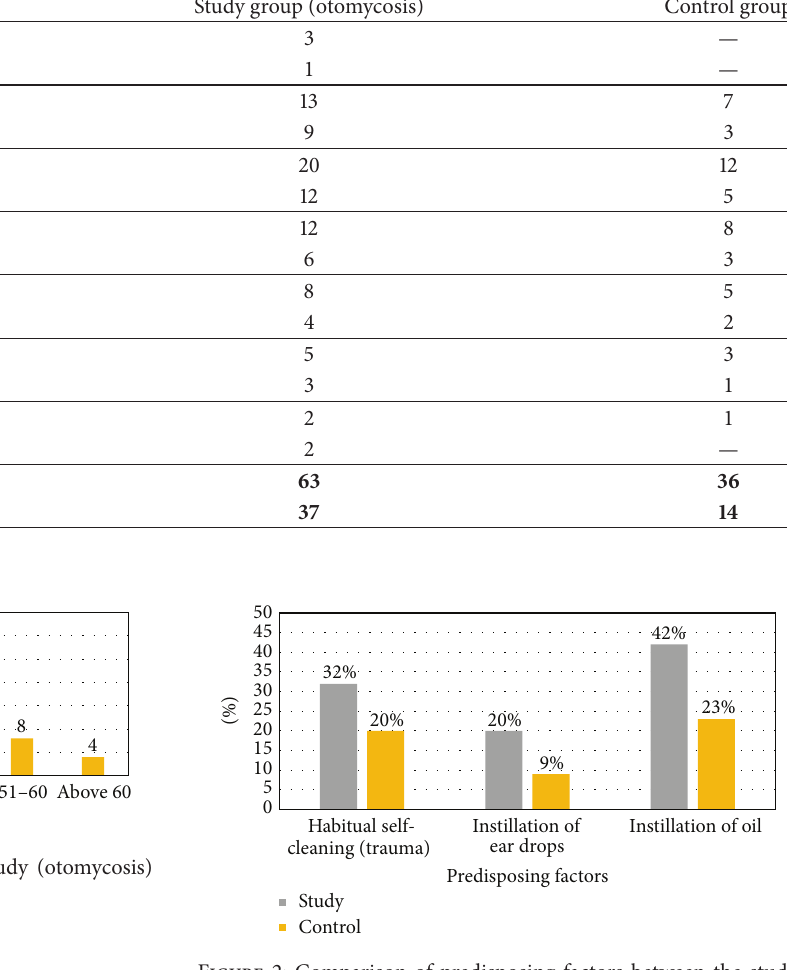
Figure 2: Comparison of predisposing factors between the study (otomycosis) and the control